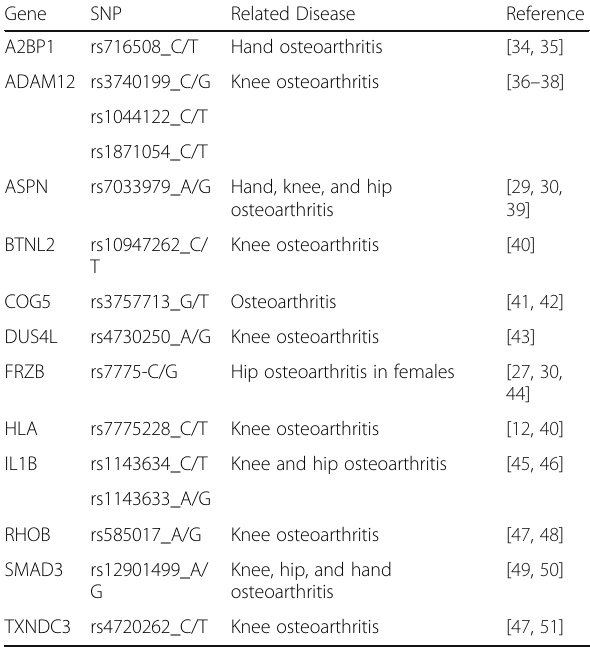
Table 2 Selected SNPs related to osteoarthritis Gene SNP Related Disease